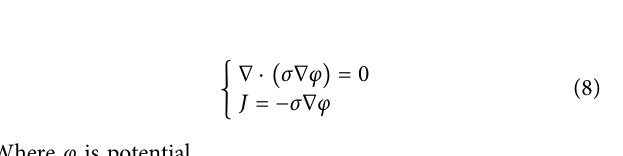
FIGURE 7 | Arc generating device. (A) Experimental platform; (B) arc-generating